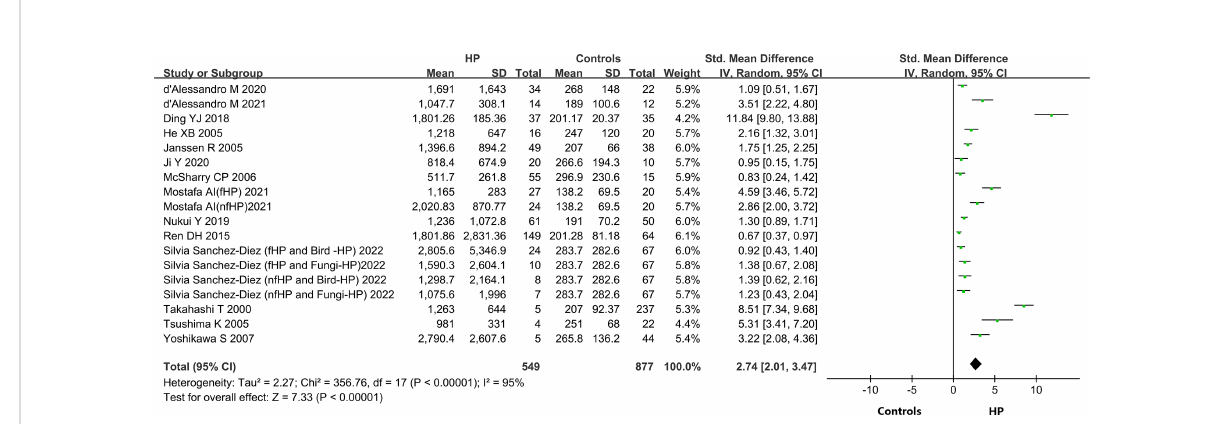
FIGURE 2 The forest plot pooled the SMD (95%) of KL-6 level between HP patients and controls.